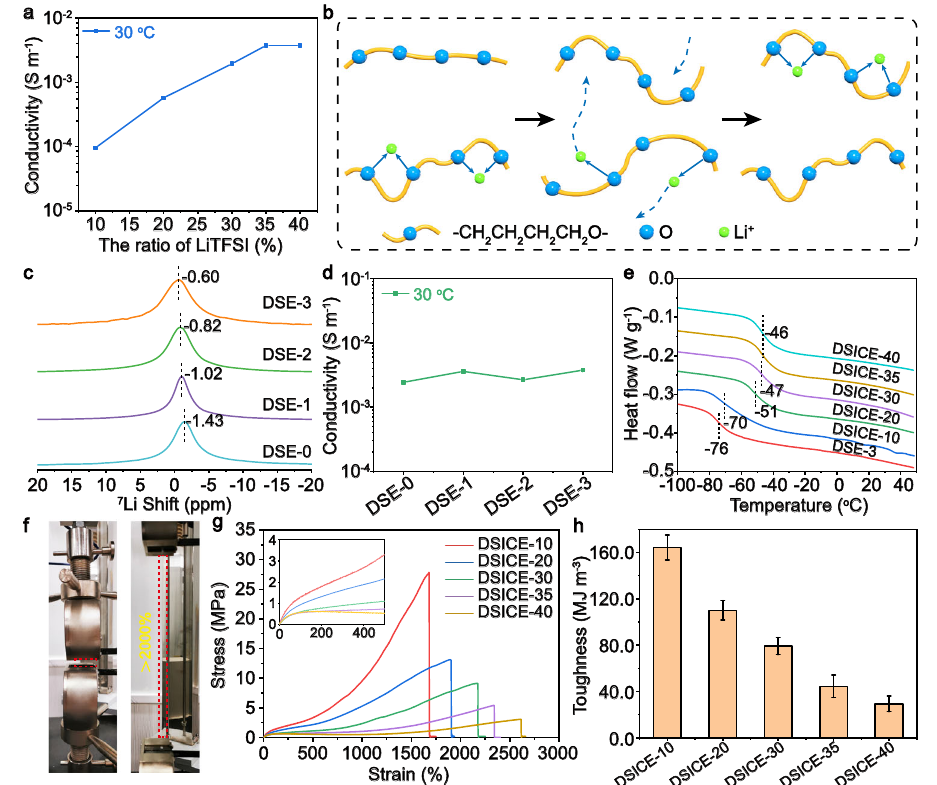
Fig. 4 | Ion transport mechanism and mechanical properties of DSICE. a Ionic conductivity of DSICE varying the amount of LiTFSI from 10 wt.% to 40 wt.% at 30°C. The ionic conductivity of DSICE-35 reaches the maximum value of 3.77×10 − 3 Sm − 1 . b Schematic illustration of Li + transporting in the PTMEG chains with loose coordination structure. c 7 Li NMR traces of DSICE (DSE-0, DSE-1, DSE-2, DSE-3with35wt.%LiTFSI). d IonicconductivityofDSE-0~3withthesameamountof 35wt.%LiTFSIat30°C.TheionicconductivityofDSE-0~3with35wt.%LiTFSIkeeps almost consistent, suggesting that the ionic conductivity of DSICE originate from the soft phase and independent on the hard phase of the polymer backbone,